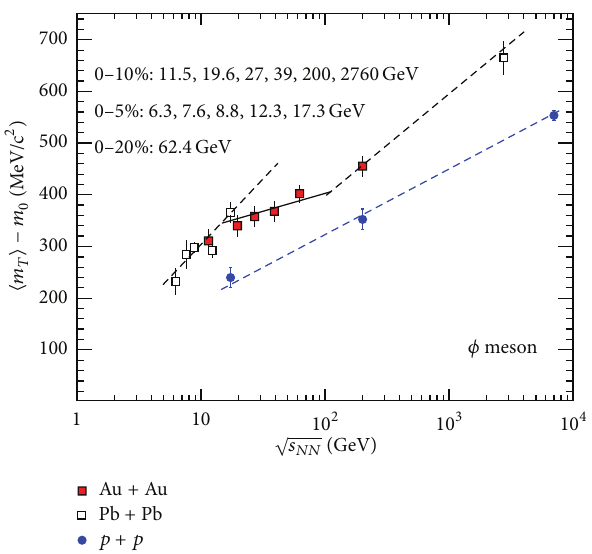
Figure 8: 𝜙/𝐾 − ratio as a function of number of participants in Au + Au [18] and Pb + Pb [21] collision at various beam